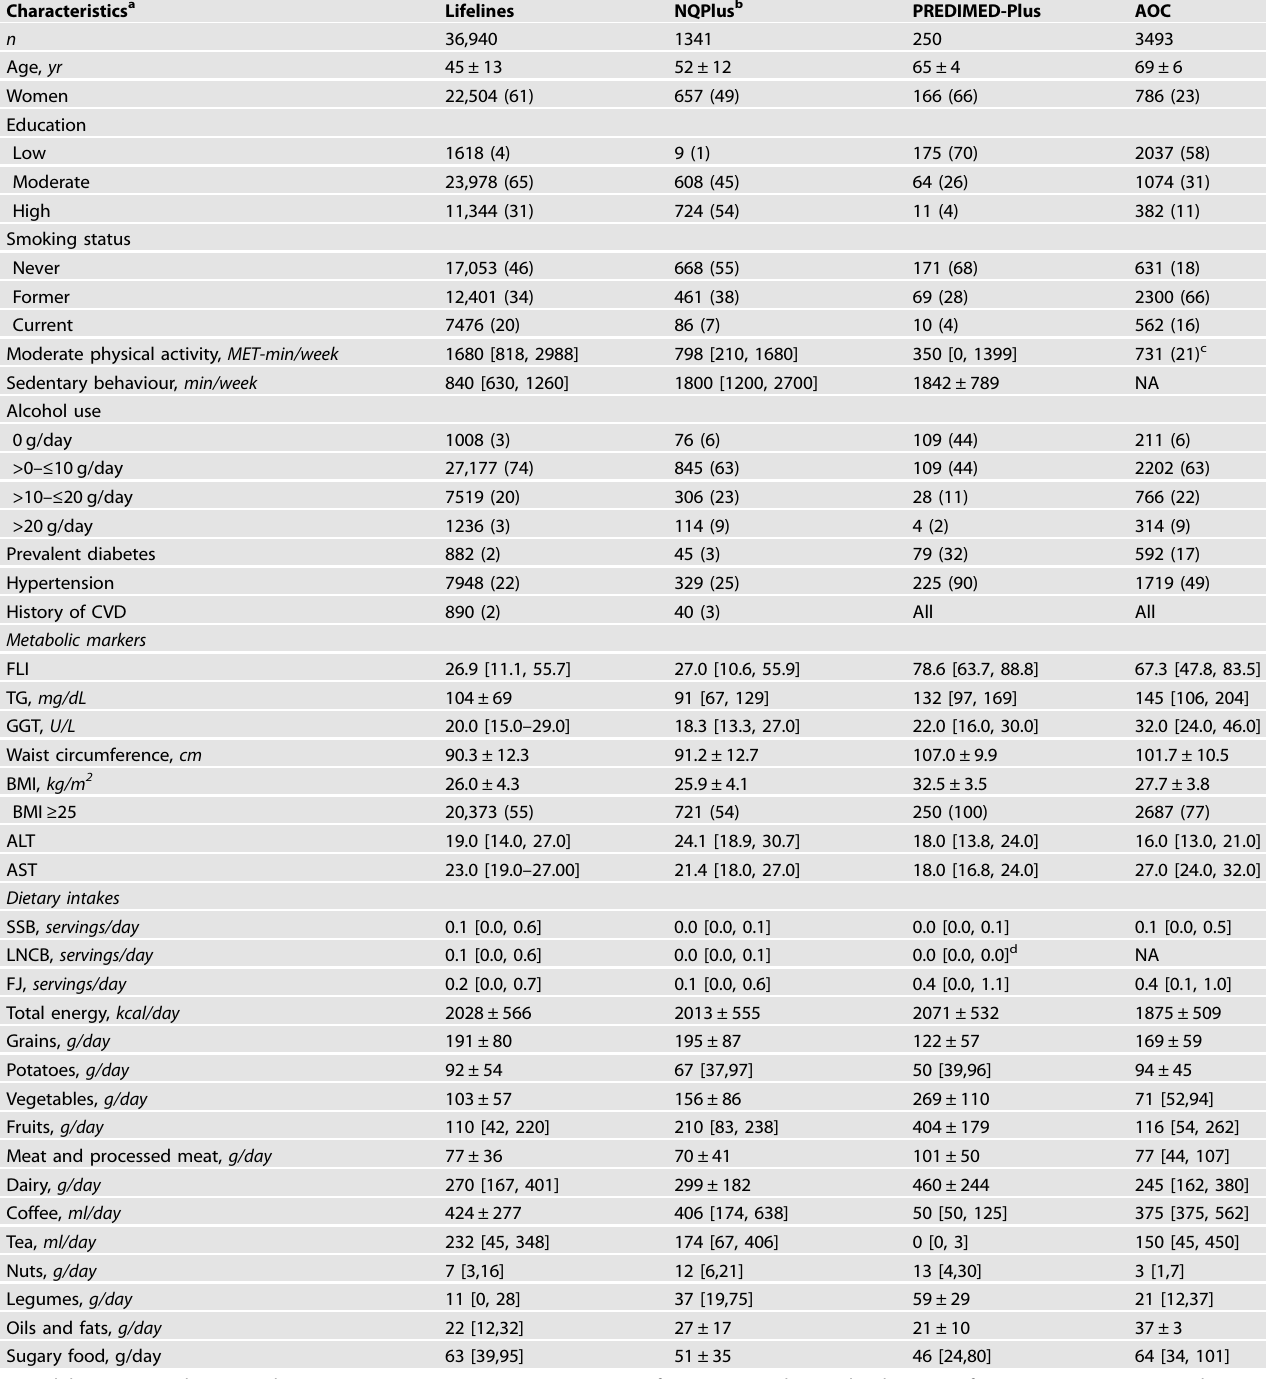
Table 1. General characteristics of Lifelines, NQPlus, PREDIMED-Plus and AOC